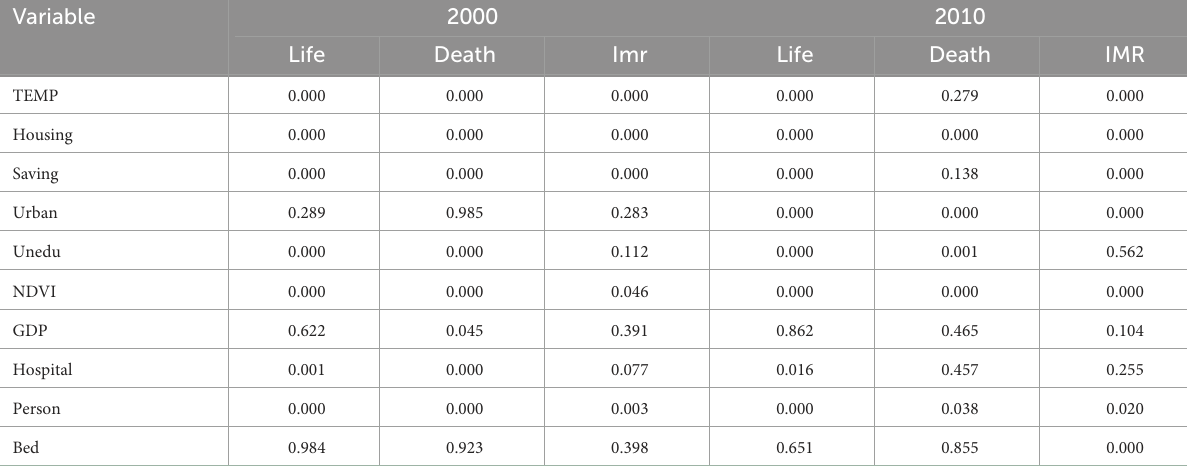
TABLE 6 MGWR regression results; p -value ( p < 0.05).